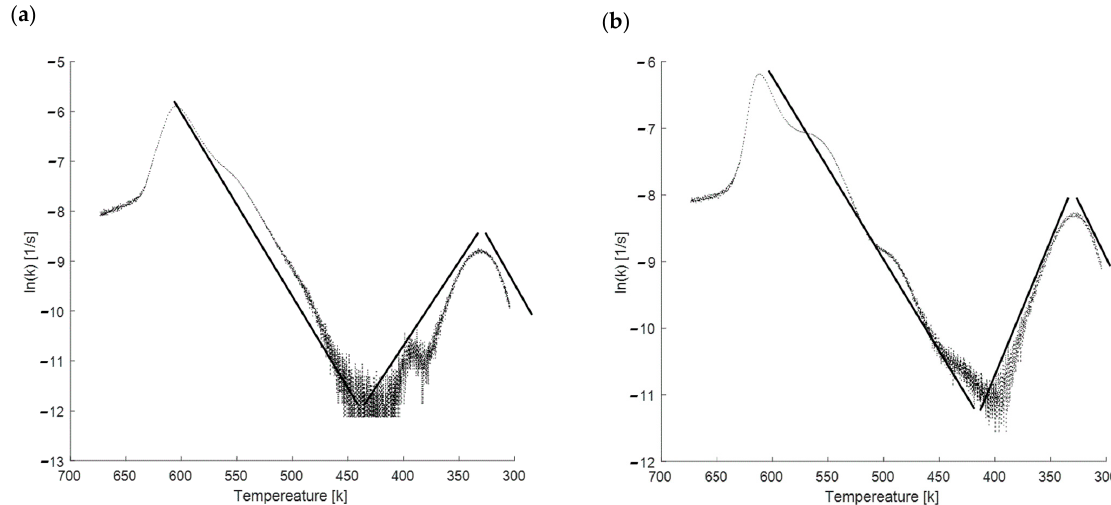
Figure 9. Arrhenius plot of TGA data measured at different heating rates of grape branch ( a ) and perilla ( b ).